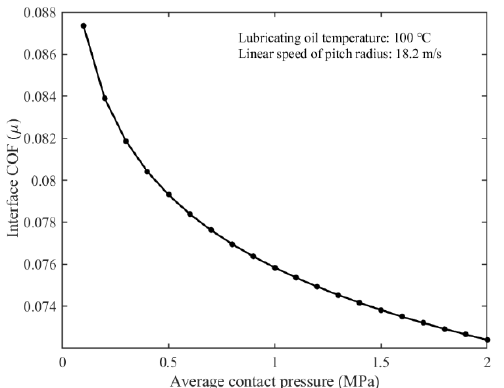
Figure 5. Variation of the interface coefficient of friction (COF) regarding the contact pressure. According to Equations (5), (7) and (8), the interface COF and contact pressure under Figure 6, the farther the friction pair from the piston is, the greater the interface COF is.